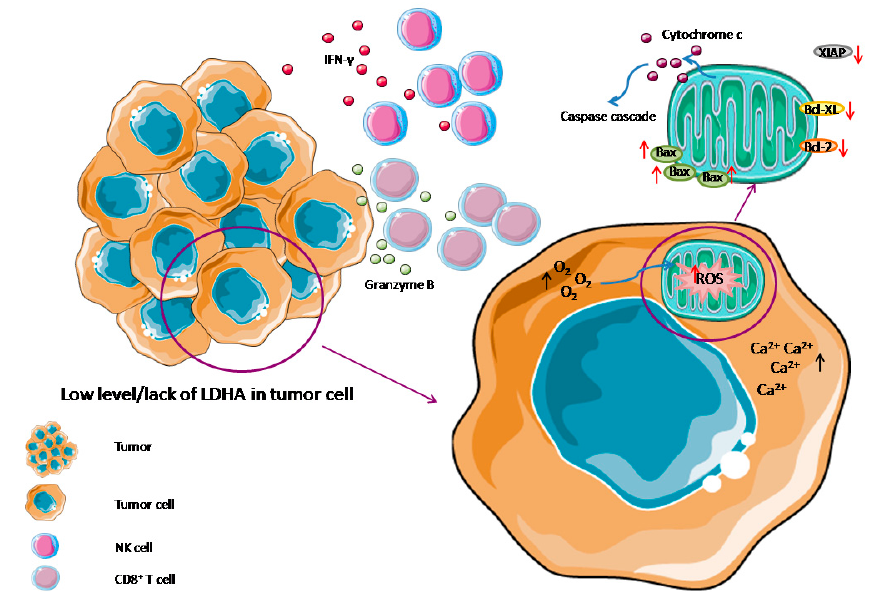
Figure 3. The role of LDHA in the apoptosis of a tumor cell. IFN- γ = interferon gamma, ROS = reactive oxygen species. Graphical elements adapted from Servier Medical Art.